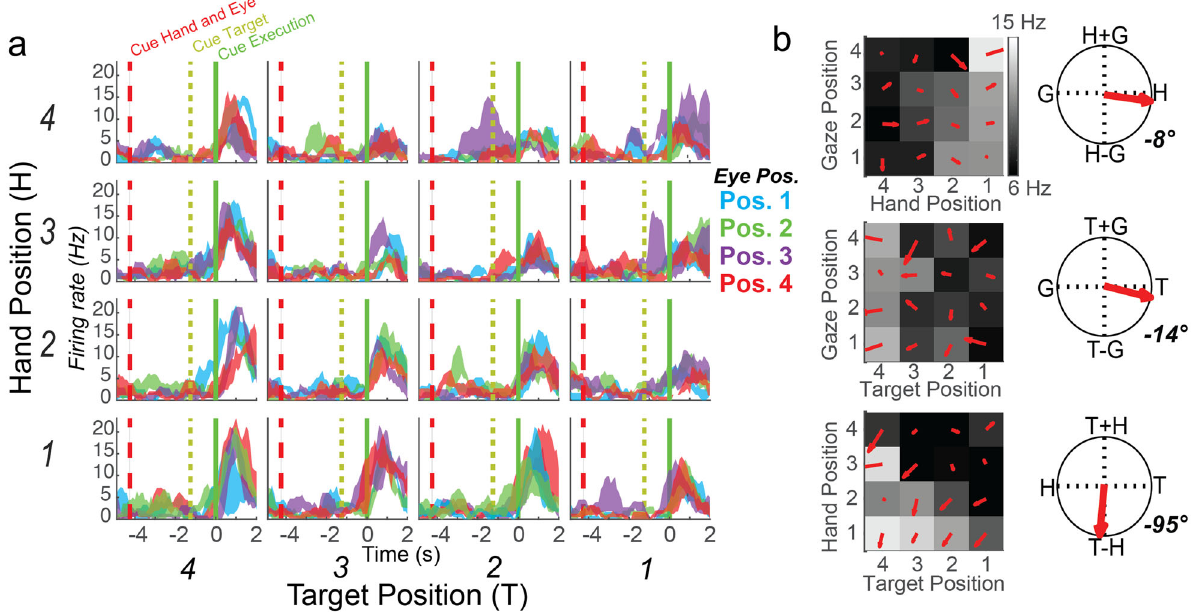
Fig. 2 Example S1 Unit illustrating selective responses and response matrices. a Peristimulus time histograms for all 64 conditions (3 trials; mean ± SEM). Each of the 16 subplots shows the response of the unit to a particular combination of eye, hand, and target position. b Response matrices, gradient fi eld, and gradient resultant orientations for the cell shown in panel a during the execution epoch.